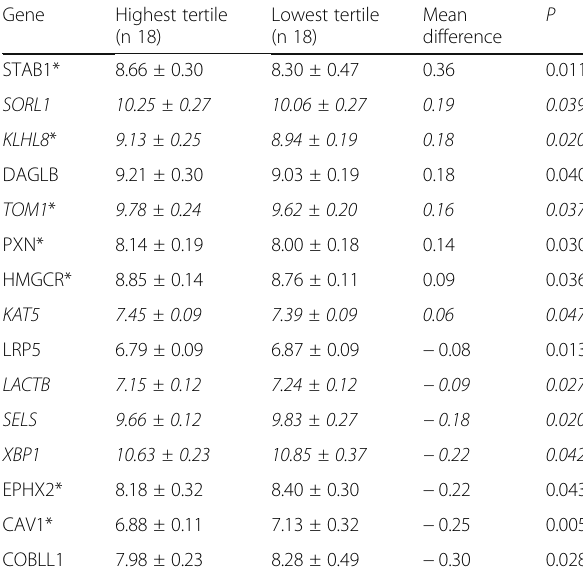
Table 5 Differentially expressed genes between subjects in the highest and lowest plasma SFA to PUFA ratio